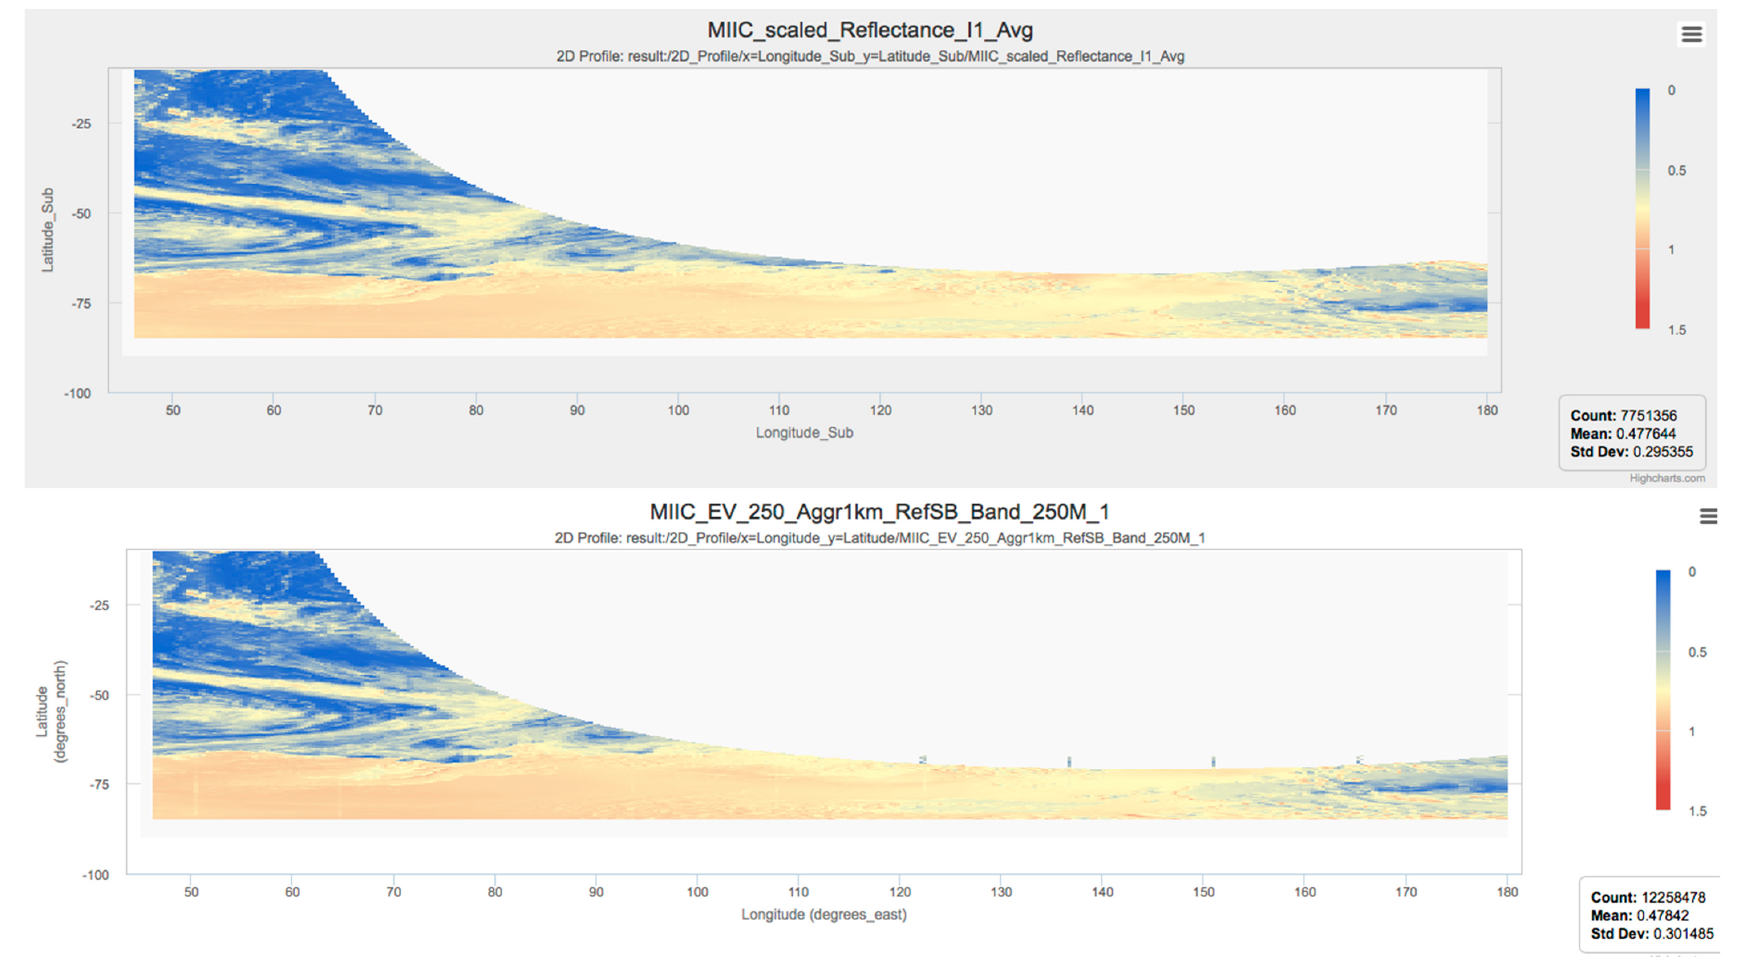
Figure 6. Single matched LEO-LEO event for VIIRS ( top ) and MODIS ( bottom ), 3 January 2015 over Antarctica. The mean difference between MODIS and VIIRS reflectance is 0.0053 ( σ = 0.0177) for matched grid cells of size 0.3°.